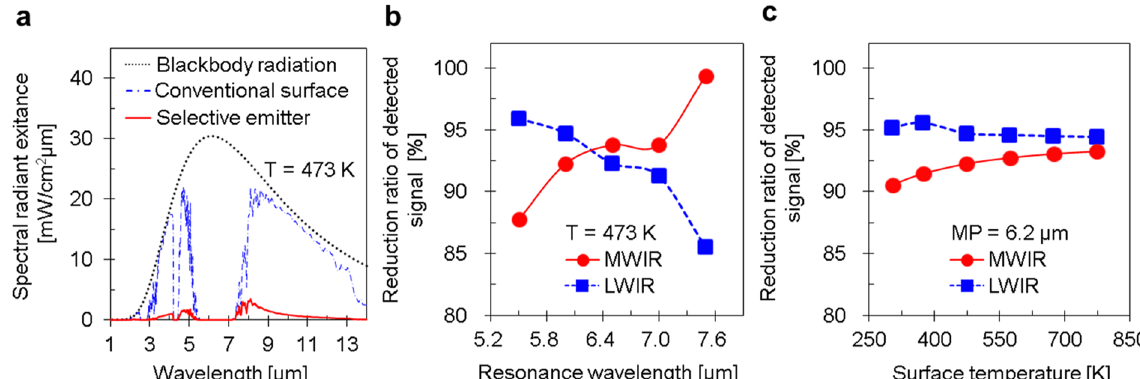
Figure 6. Usability of the dual-band metamaterial perfect absorber in IR stealth technology. ( a ) Spectral radiant exitances of a blackbody (calculated using Planck’s radiation law at 473 K (dotted line)), a conventional surface (dashed-dotted line), and the perfect absorber (solid line), assuming a 1-km-long transmission path through the atmosphere at ground level. ( b ) Reduction rates of IR signatures in the MWIR and LWIR wavelength ranges (3–5.5 μ m and 8–14 μ m, respectively) for various wavelengths of the ring-excited MP resonance. The reduction rates were determined by comparing the spectral radiances emitted by the perfect absorber and a blackbody, which were transmitted through the atmosphere. ( c ) The same ratios as in ( b ) calculated for various surface temperatures with a resonance wavelength of 6.2 μ m.